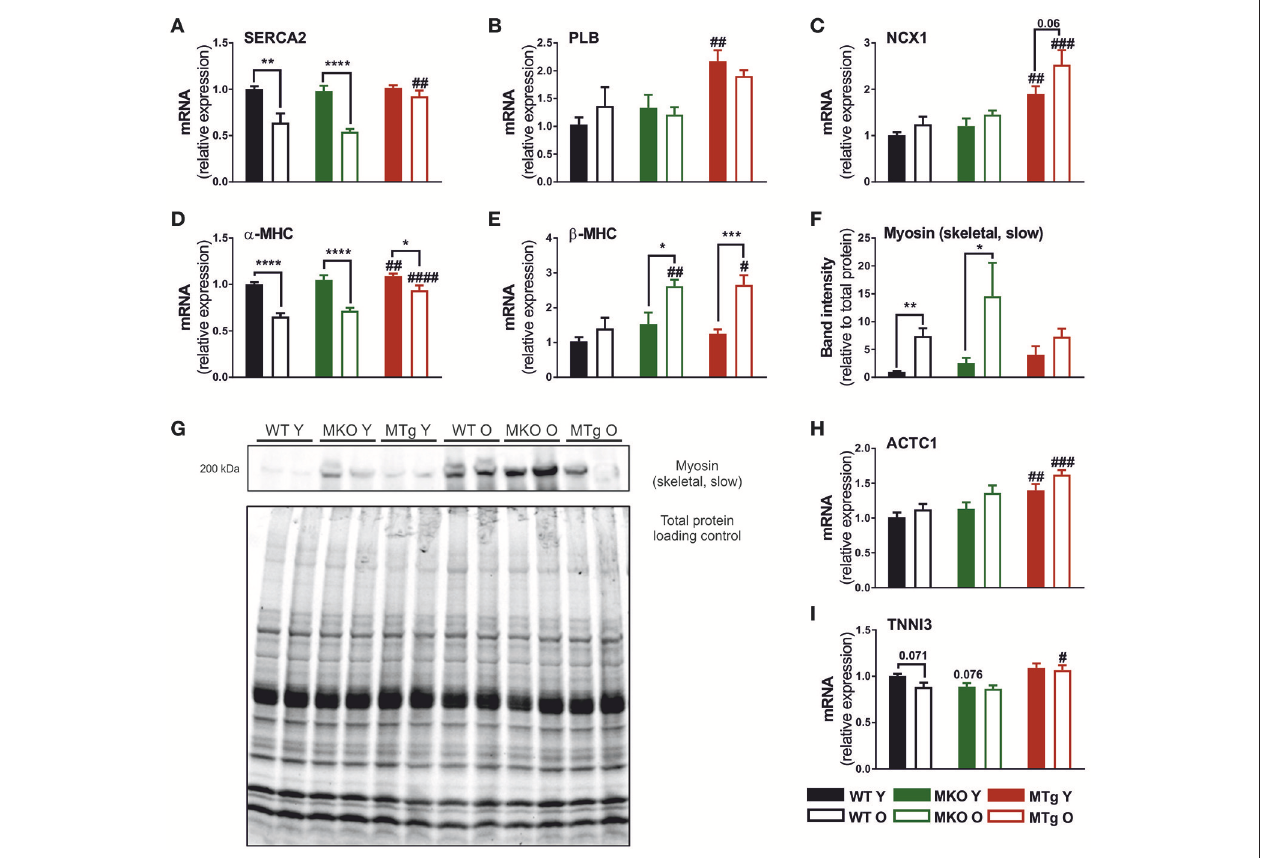
FIGURE 4 | Increased PGC-1 α blunts the age-associated regulation of calcium homeostasis and contractile genes. Gene expression levels of (A) SERCA2, (B) PLN, (C) NCX1, (D) α -MHC, (E) β -MHC, (H) ACTC1, and (I) TNNI3 ( n = 6/group). (F,G) Western blot and quantification ( n = 6/group) of myosin (skeletal, slow), which represents β -MHC in the heart, normalized to total protein loading control. Data are means ± SEM of values from each group. Significant age/genotype-associated differences ( p < 0.05) are indicated by asterisks (*) and by hashtags (#, compared to WT) respectively (*/#: p < 0.05; **/##: p < 0.01; ***/###: p < 0.001; ****/####: p < 0.0001 indicates age/genotype related significant differences). ACTC1, actin, alpha, cardiac muscle 1; PLB, phospholamban; MHC, myosin heavy chain; NCX1, sodium/calcium exchanger protein 1; O, old; SERCA2, sarcoplasmic/endoplasmic reticulum Ca 2 + transporting ATPase 2; TNNI3, troponin I3, cardiac type; Y,